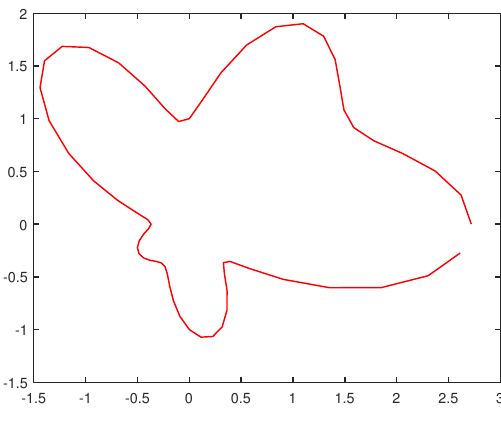
Figure 3. Irregular amoeba-like